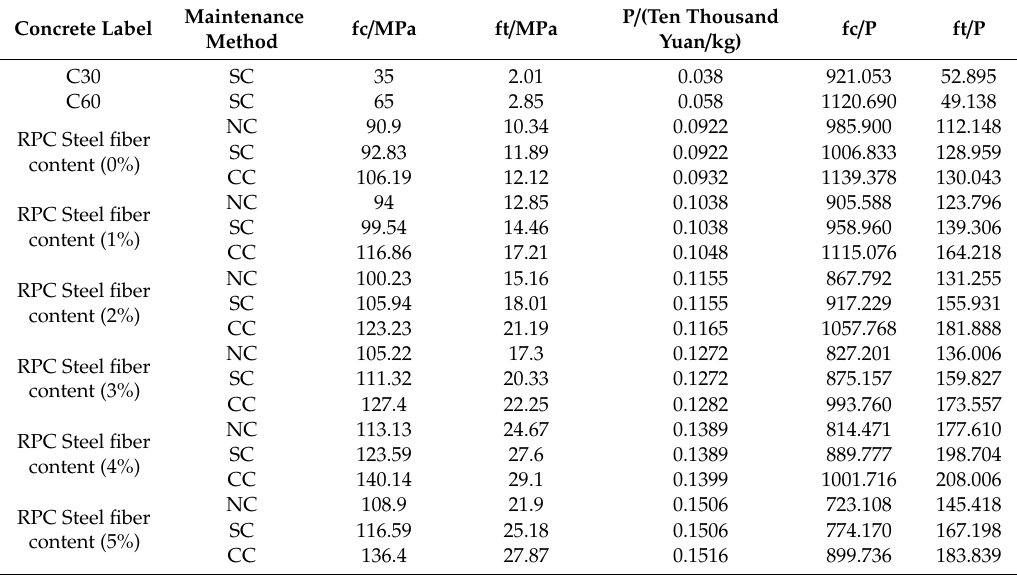
Table 15. RPC cost performance